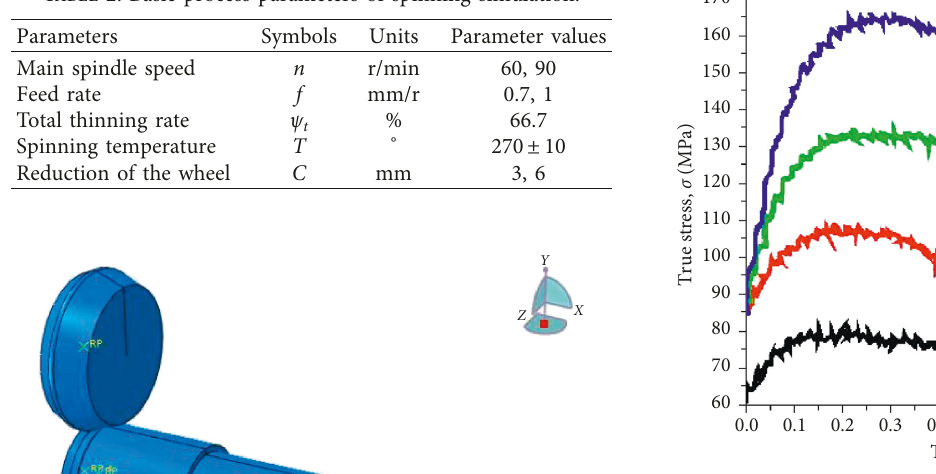
Figure 5: Stress-strain curve with a strain rate of 0.1s − 1